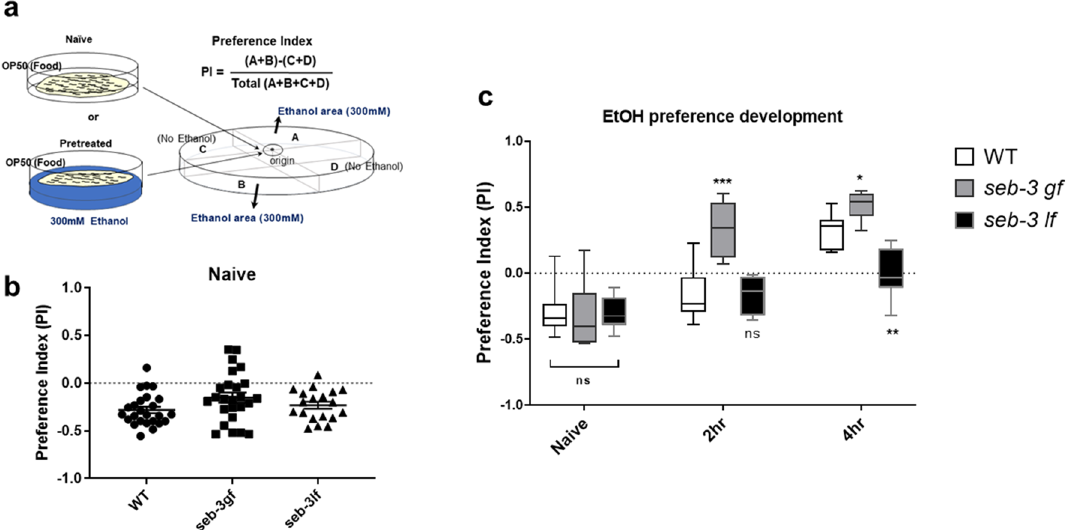
Figure 4. SEB-3 facilitates the development of ethanol preference. ( a ) Diagrammatic representation of ethanol preference assay. Naïve or ethanol pretreated animals remain free to explore on the quadrants plate before counting. ( b ) Naïve animals accumulate primarily in the non-ethanol region. One-way ANOVA, p > 0.05, F (2, 66) = 2.539, ns compared to WT in post hoc multiple comparison test; Dunnett’s. ( c ) Ethanol preference developed more rapidly and greater in seb-3gf animals, whereas impaired in seb-3lf animals. [Fgenotype(2, 27) = 15.76, p < 0.0001; Ftime(1.871, 37.42) = 72.56, p < 0.0001; FGenotype × time(4, 40) = 9.982, p < 0.001]. A two- way ANOVA comparison showed significant differences based on genotype, time, and the interaction of the two. Significant post hoc differences (Bonferroni’s multiple comparison test) between the genotypes (WT vs. seb-3gf ) or (WT vs. seb-3if ) at naïve, 2 h, and 4 h are shown ( p < 0.05,*; p < 0.01,**; p <